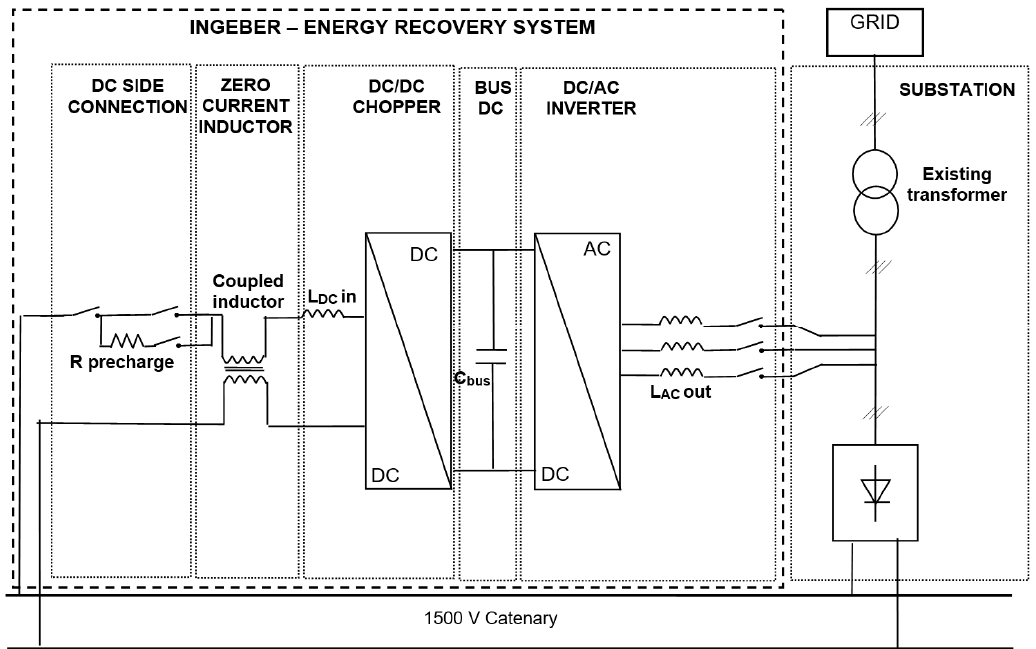
Figure 4. Schematic diagram of the INGEBER system integrated into an existing DC-traction substation with uncontrolled rectifier